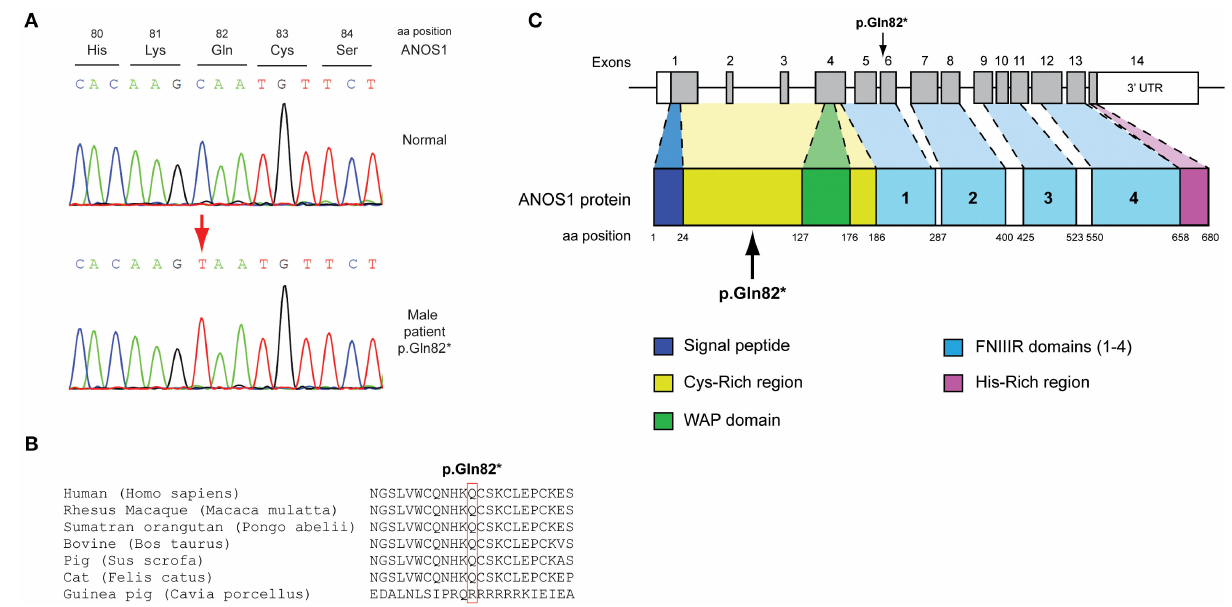
of cryptorchidism, micropenis and gynaecomastia ( Table 1 , Figure 5 , Supplementary Figure 2 ). The known